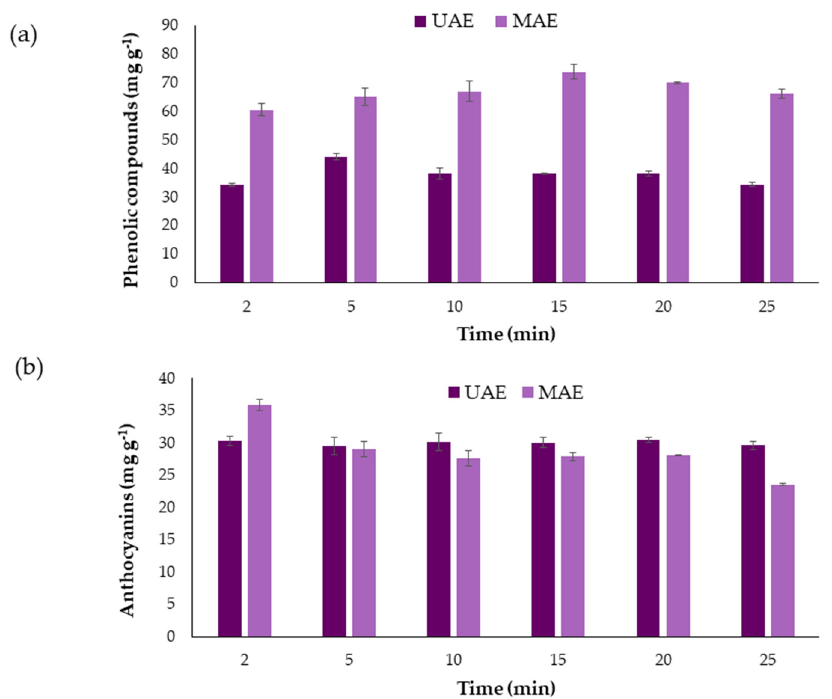
Figure 5. Comparison between the implementation of UAE and microwave-assisted extraction (MAE) to myrtle berries: ( a ) To extract total phenolic compounds; ( b ) to extract anthocyanins.